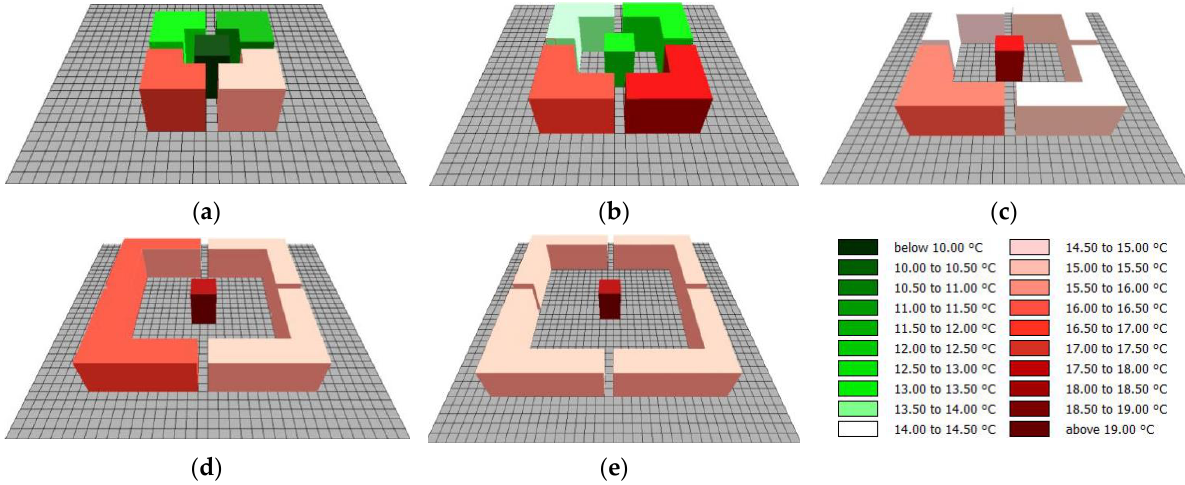
Figure 3. Simulation results at 16:00 in January. ( a ) Indoor air temperature at 16:00 in January for the SVF (0.05) scenario. ( b ) Indoor air temperature at 16:00 in January for the SVF (0.18) scenario. ( c ) Indoor air temperature at 16:00 in January for the SVF (0.3) scenario. ( d ) Indoor air temperature at 16:00 in January for the SVF (0.4) scenario. ( e ) Indoor air temperature at 16:00 in January for the SVF (0.45) scenario.To further understand the daily variations of indoor air temperature, we con- ducted a statistical analysis of indoor temperature changes under the five SVF scenarios in every month, the results of which are presented in Figure 4.